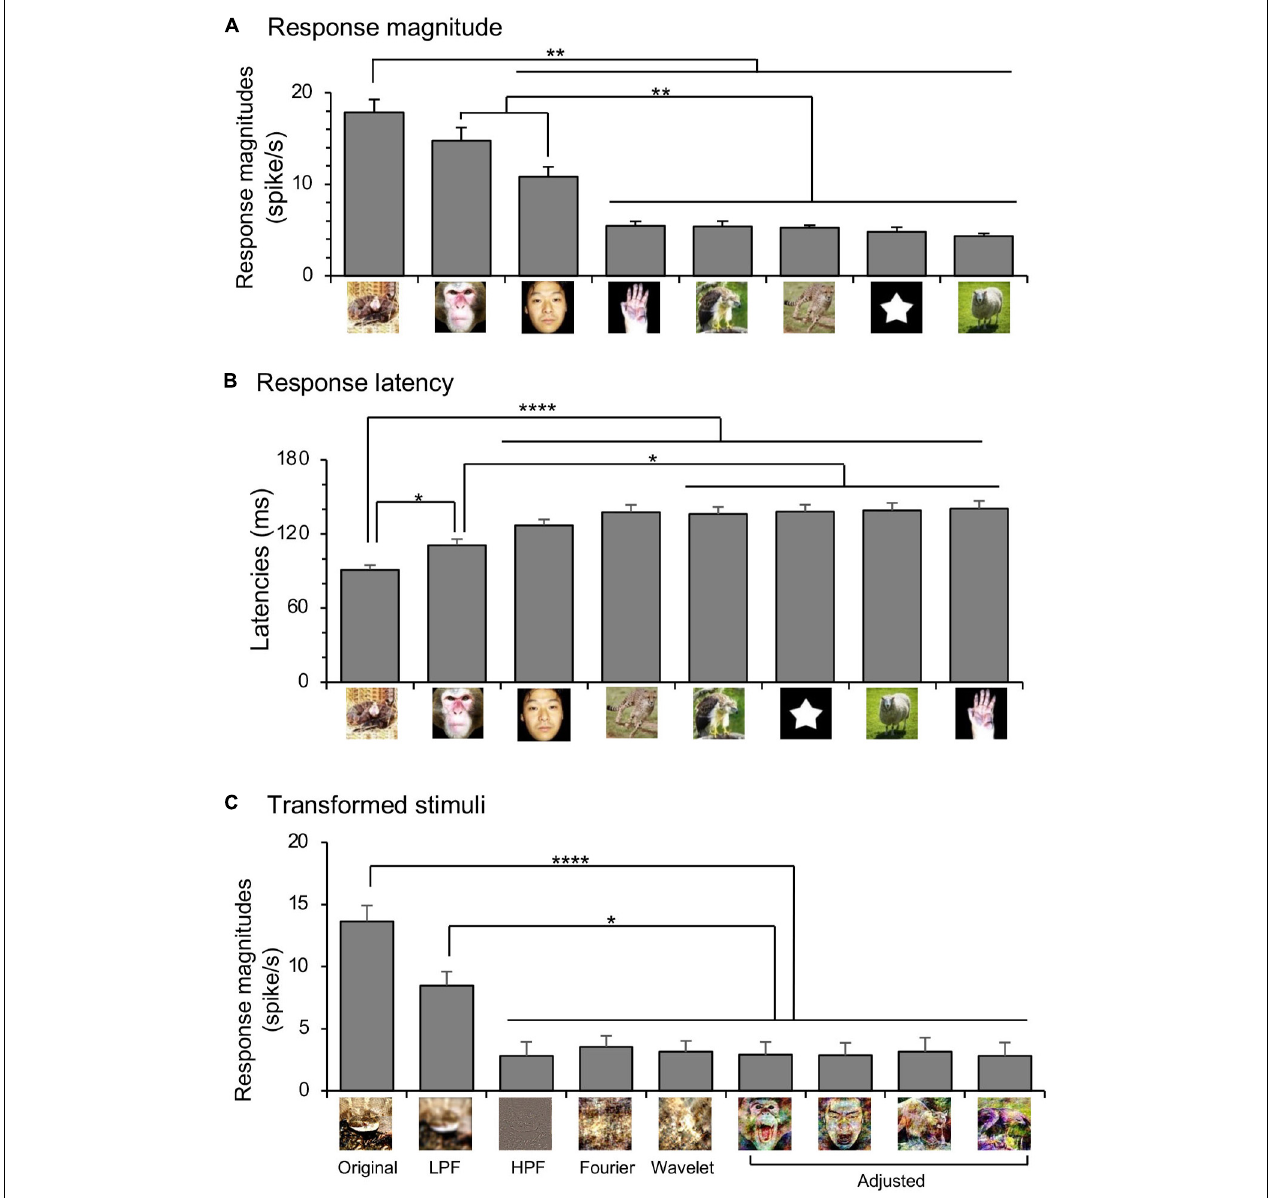
FIGURE 3 | Response characteristics of the amygdala neurons to the eight categories of the visual stimuli (A,B) and the transformed stimuli (C) . (A) Comparison of the mean response magnitudes to the eight stimulus categories. **, p < 0.01, respectively (Bonferroni test after repeated measures one-way ANOVA). (B) Comparison of the mean response latencies to the eight stimulus categories. ****, *, p < 0.0001, 0.05, respectively (Bonferroni test after repeated measures one-way ANOVA). (C) Comparison of averaged response magnitudes of 26 amygdalar neurons to the original and transformed images. Original, original snake images; LPF, low pass-filtered snake images; HPF, high pass-filtered snake images; Fourier, Fourier-scrambled snake images; Wavelet, Wavelet-scrambled snake images; Adjusted, adjusted images. ****, *, p < 0.0001, 0.05, respectively (Bonferroni